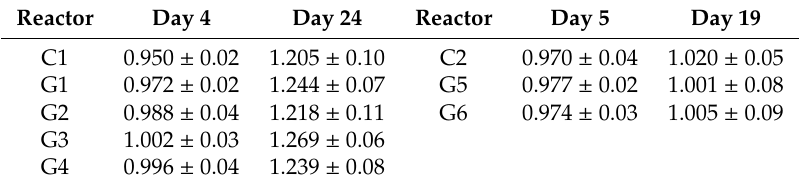
Table 1. Total ammonia nitrogen concentration (g L − 1 ) detected in reactors (mean ±